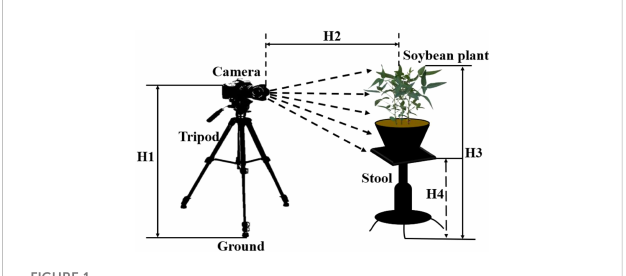
FIGURE 1 Schematic diagram of acquisition device for soybean plants images.